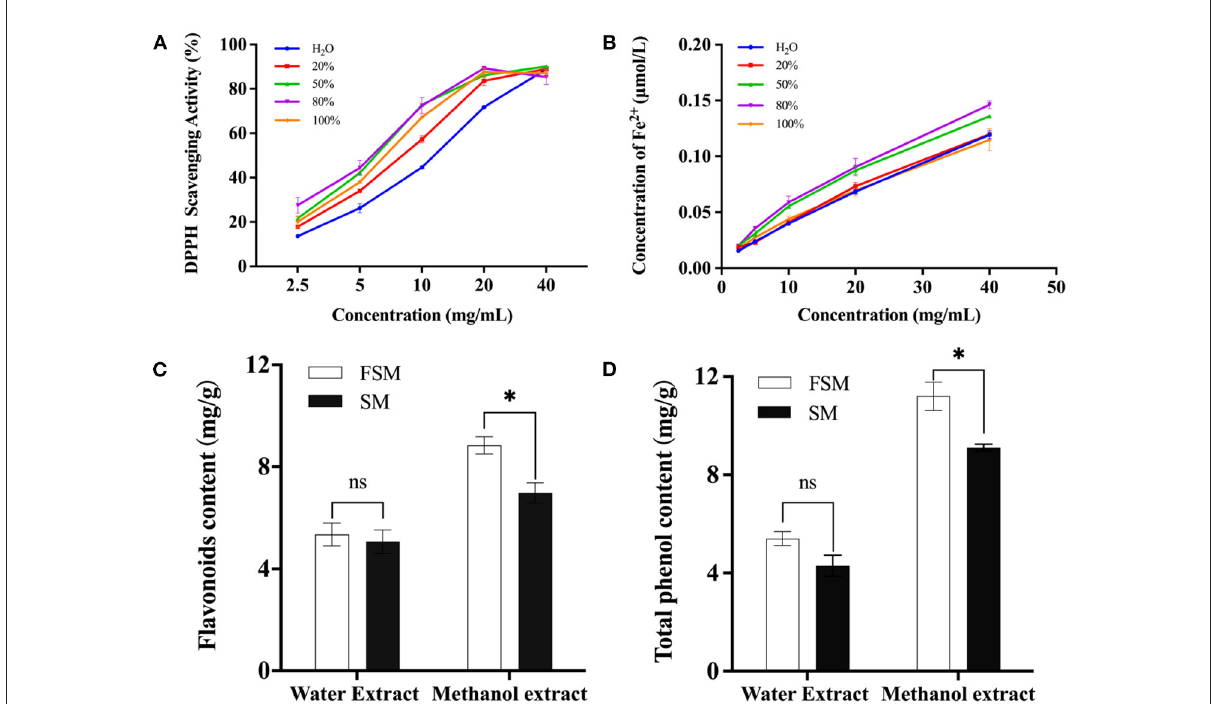
FIGURE3 Effect of fermented soymilk active components extraction methods on antioxidant activity; (A) DPPH scavenging ability of fermented soymilk extract with different methanol concentrations; (B) Total reducing ability of the extract with different methanol concentrations; (C) Flavonoid content of the extract with water and 80% methanol; (D) Total phenolic content of the extract with water and 80% methanol. * indicates p < 0.05 according to Tukey’s HSD tests.